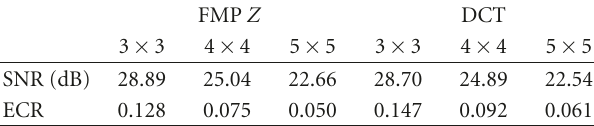
Table 7: Comparison for two-dimensional FMP and DCT.